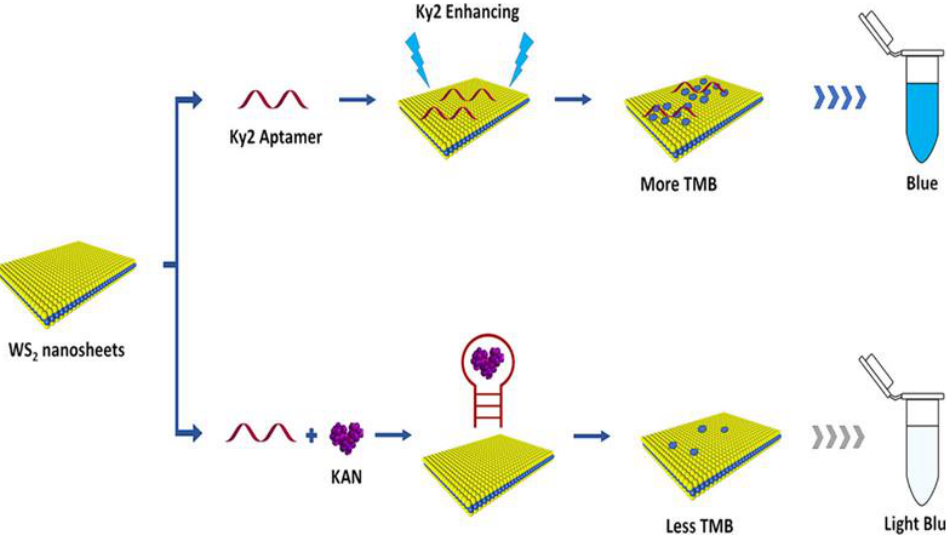
Figure 3. The colorimetric detection of kanamycin residue (Ky2) based on the aptamer-enhanced peroxidase-mimicking activity of the layered WS 2 nanosheet. Reprinted with permission [118], copyright 2021, American Chemical Society.